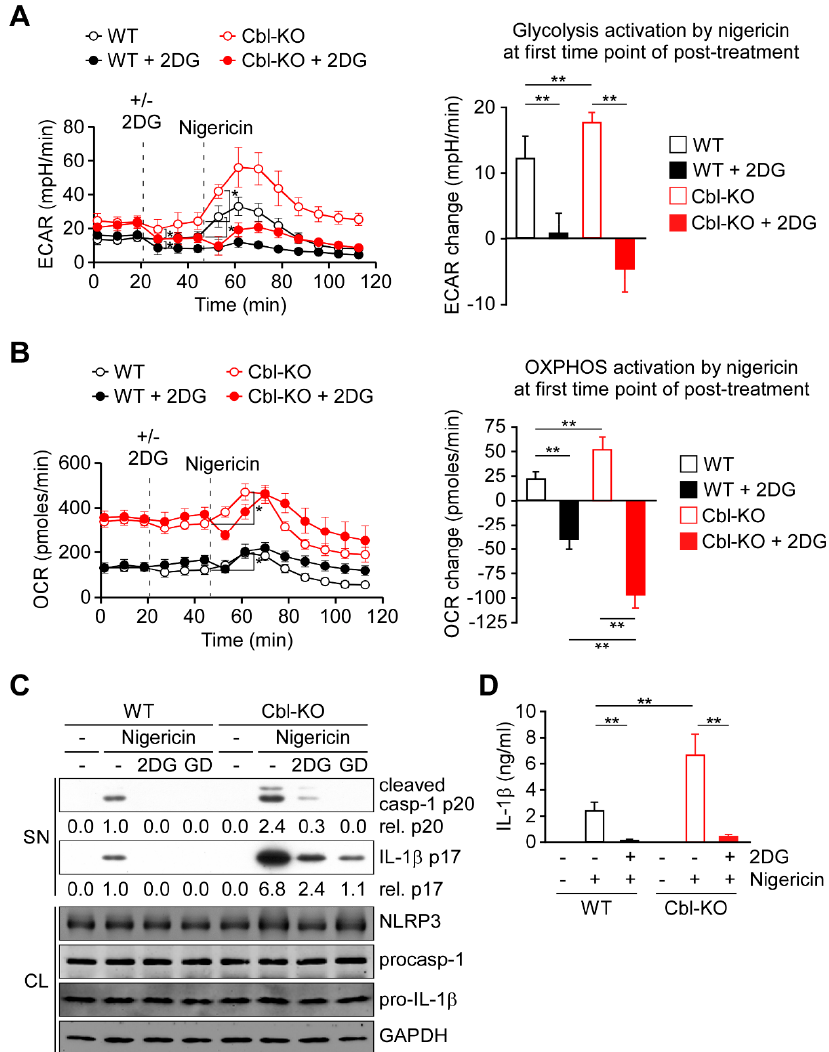
Figure 2. Cbl deficiency promoted NLRP3 inflammasome activation via upregulation of glycolysis. ( A ) ECAR of WT and Cbl-KO THP-1-derived macrophages under sequential treatment (dotted vertical lines) with or without 2DG and treated with nigericin. The change in ECAR between before and after nigericin treatment is calculated in the right panel. ( B ) OCR of WT and Cbl-KO THP-1-derived macrophages under sequential treatment (dotted vertical lines) with or without 2DG and treated with nigericin ( B ). The change in OCR between before and after nigericin treatment is calculated in the right panel. ( C ) Immunoblot analysis of caspase-1 (p20) and IL-1 β (p17) in culture supernatants (SN), and NLRP3 inflammasome molecules and glyceraldegyde 3-phosphate dehydrogenase (GAPDH) in cell lysates (CL) of WT and Cbl-KO THP-1-derived macrophages that were treated with 2DG or glucose deprivation and then stimulated with nigericin. ( D ) Enzyme-linked immunosorbent assay of IL-1 β in the supernatants of WT and Cbl-KO THP-1-derived macrophage cultures pretreated with or without 2DG and then stimulated with nigericin. ** p < 0.01. All results are presented as the mean ± SD of three independent experiments and were analyzed using Student’s t